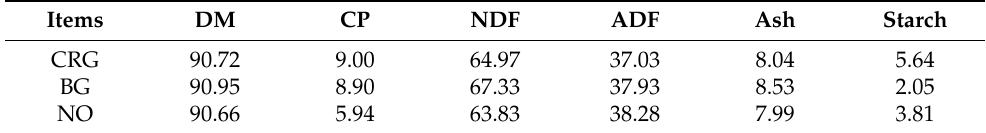
Table 3. Chemical composition of CRG, BG and NO (% DM